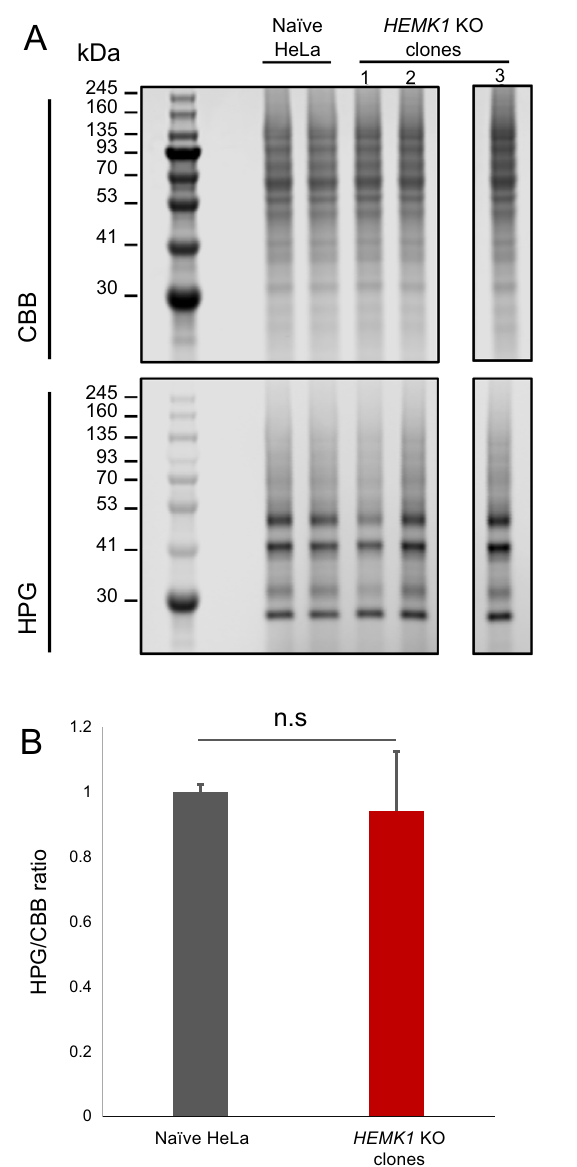
Figure 4. The assessment of mitochondrial translation in HEMK1 KO cells. ( A ) Representative gel images of total and nascent mitochondrial proteins. Infrared (IR)-800 dye was conjugated to HPG-containing newly synthesized proteins. Total protein was stained with CBB. A black line is inserted between lanes 4 and 5 (counting from the left-hand side) because they were not adjacent lanes, although these lanes are originated from the same gel. The original image is shown in Figure S6A. ( B ) Bar graph of HPG signal/CBB signal for ( A ). Error bars represented the mean ± SEM calculated from samples shown in Figure S6A (see detailed measurements in Figure S6A). The Student’s t test, two-tail, was used for testing the statistical